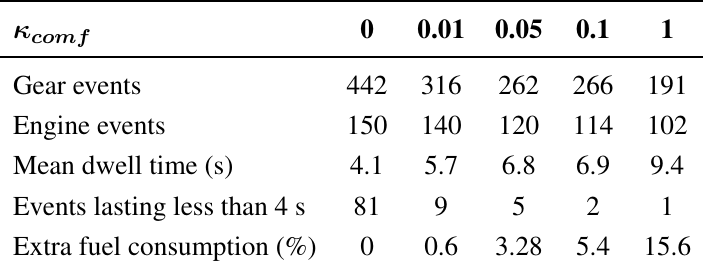
Table 1. Drivability metrics on the WLTC (Worldwide Harmonized Light Vehicles Test Cycle) for different values of κ comf